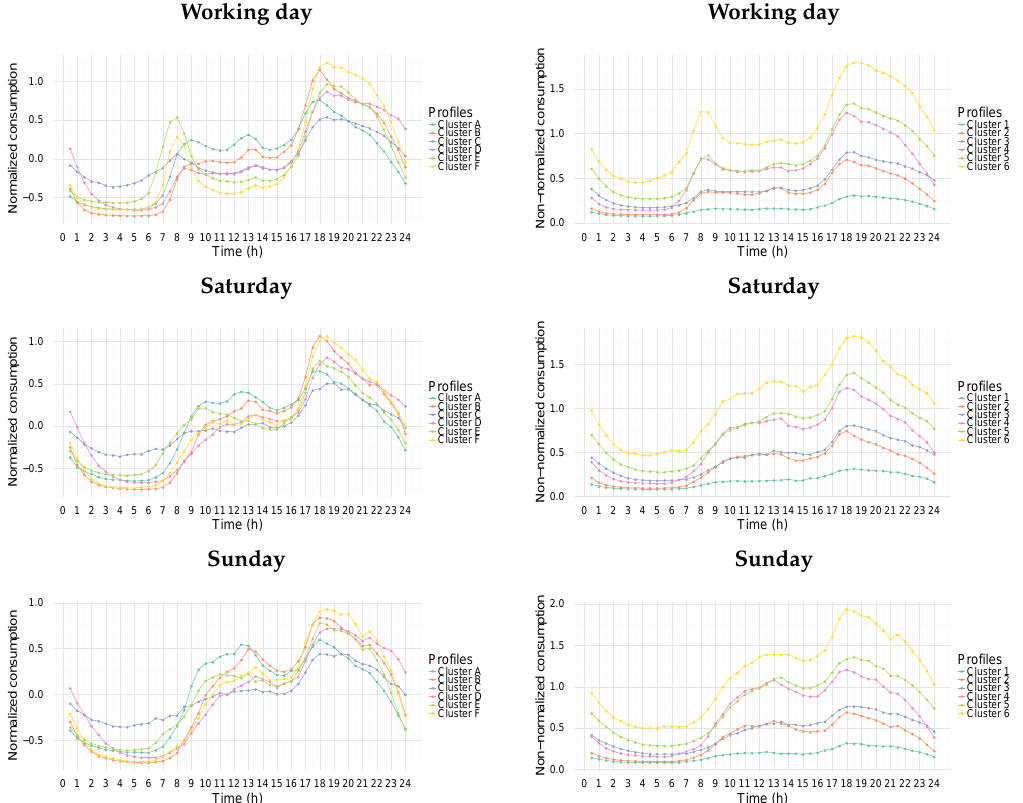
Figure 6. Electricity consumption profiles with and without normalization during Saturday, Sunday and working